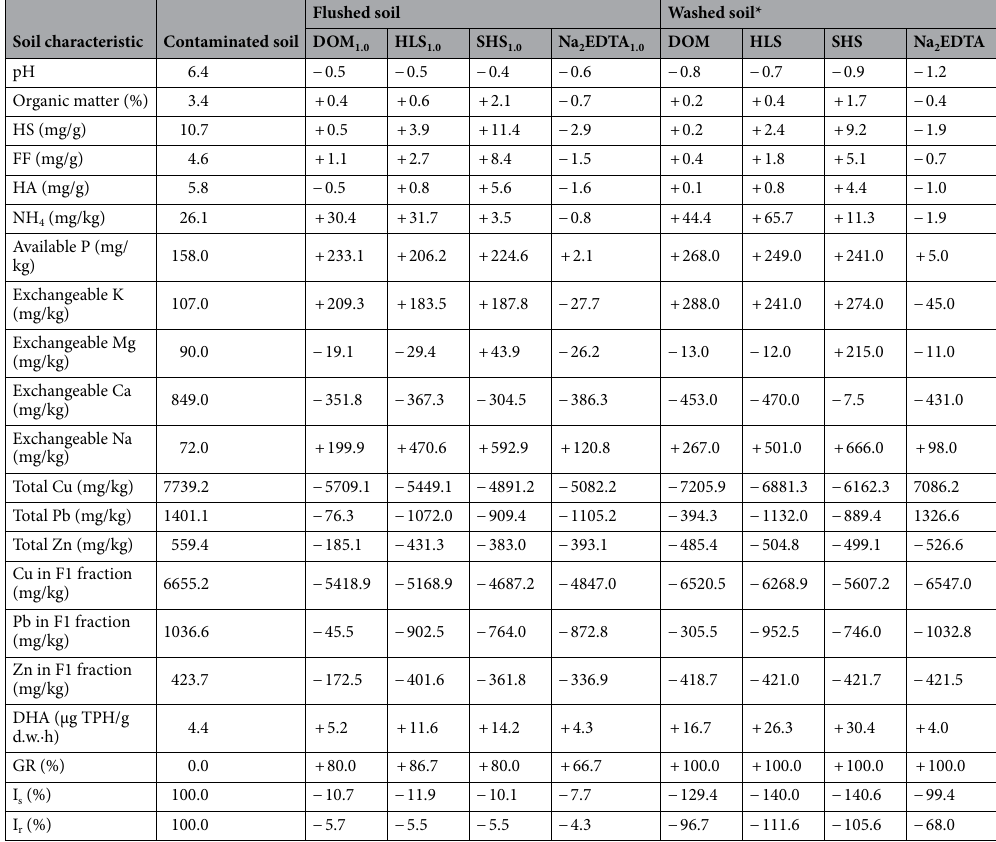
Table 4. Comparison of the quality for contaminated, flushed and washed soil with DOM, HLS, SHS and Na 2 EDTA. The sign ‘−‘ and ‘ + ’ means a decrease or an increase, respectively in the value of a given soil characteristic in comparison to contaminated soil. *Klik et al. 13